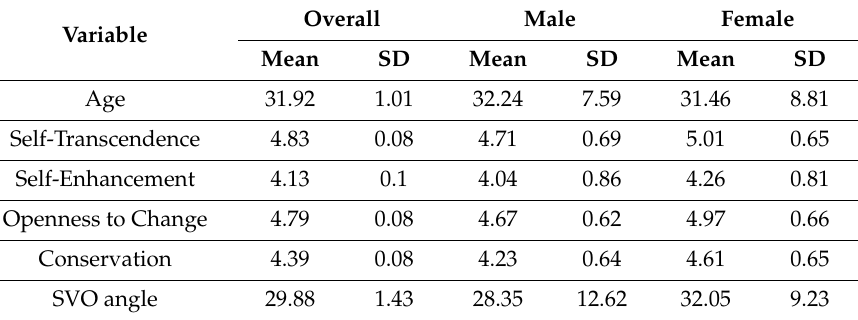
Table 3. Descriptive